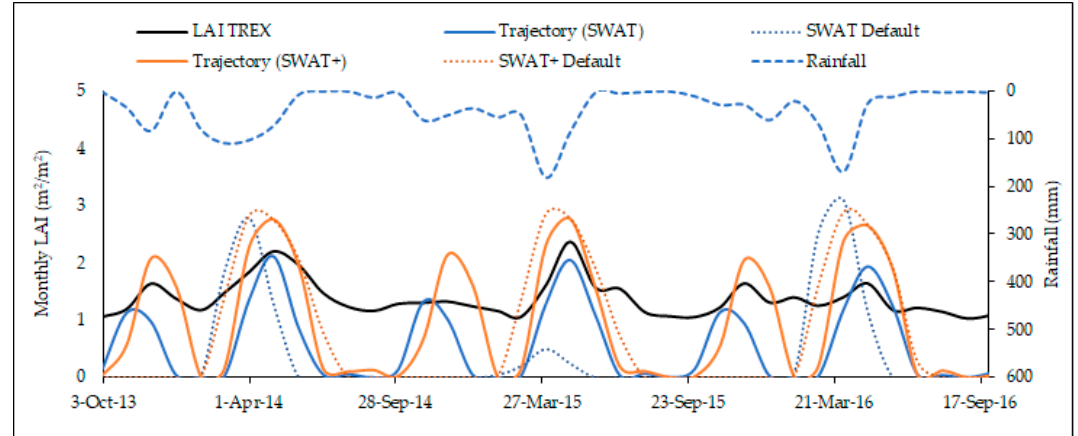
Figure 5. LAI comparison of the rainfed-maize land use for default and trajectory implementation.